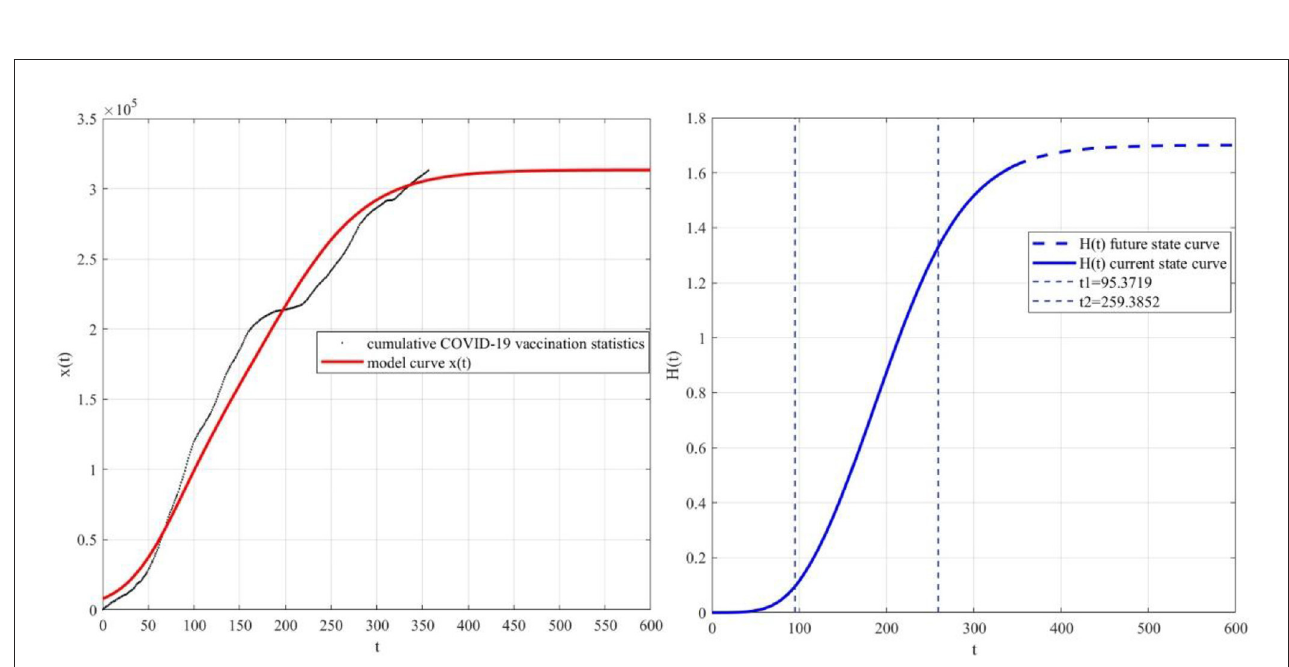
FIGURE10 Real data, x ( t ) and H ( t )